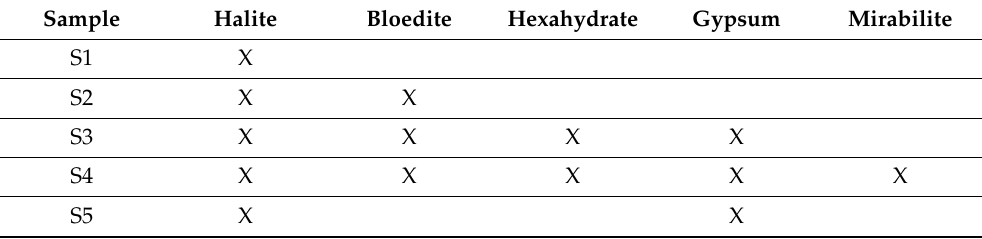
Table 3. Summary of the XRD, TG and SEM